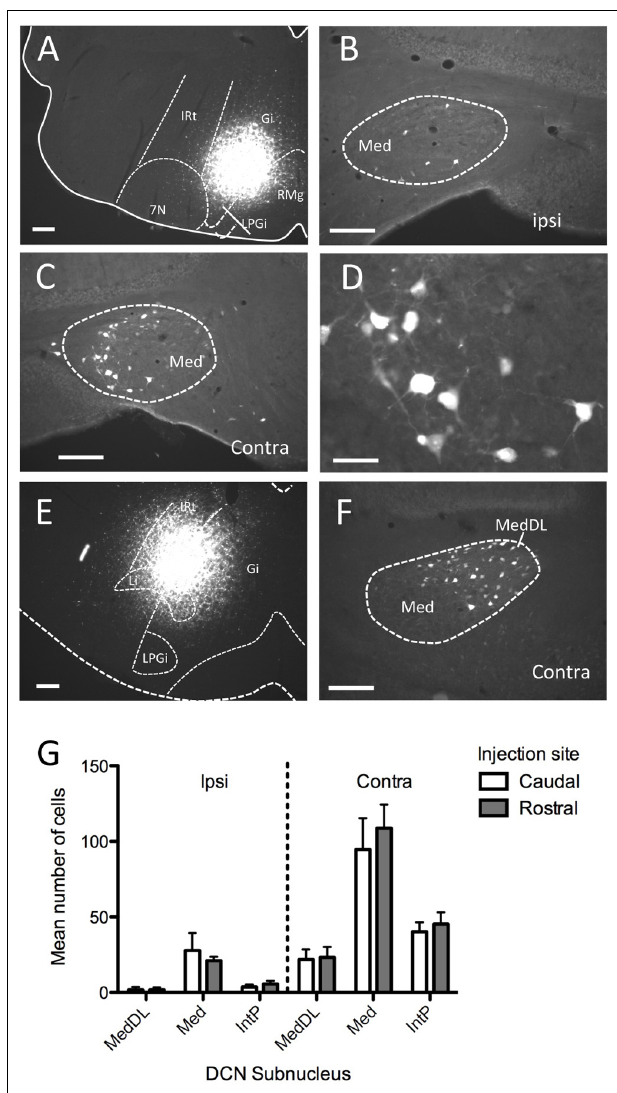
FIGURE 2 | Injection of the retrograde tracer Fluorogold into ventromedial brainstem labels neurons in the mDCN. (A–D) Following injection into Gi in the rostral medulla (A) neurons were sparsely labeled in the ipsilateral mDCN (B) , whereas greater numbers of neurons were labeled in the contralateral mDCN (C) .The rostral–caudal level for (B,C) is approximately − 6.2 mm from bregma. (D) Higher magnification of retrogradely labeled neurons from (C) . (E,F) Following injection into the Gi and LPGi at a more caudal level of the medulla (E) , neurons are labeled in the contralateral mDCN, including MedDL (F) ; approximate level is − 6.6 mm from bregma). (G) Quantification of labeled cells in DCN subnuclei from mice with tracer injections placed caudally (open bars) or rostrally (shaded bars; n = 6 per group) reveals no significant difference between the groups. For both groups, significantly more labeled cells were found on the contralateral side ( p < 0.0001). Scale bars: (A–C,E,F) = 200 mm; (D) = 50